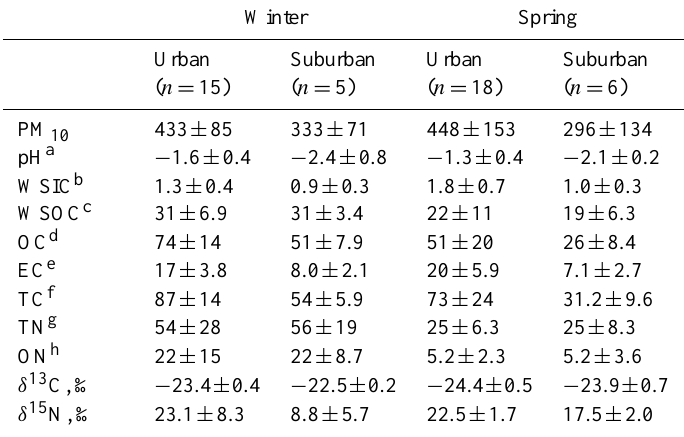
Table 1. Concentrations of major components and C and N isotopic compositions of PM 10 in Baoji City, China (µgm − 3 ) .